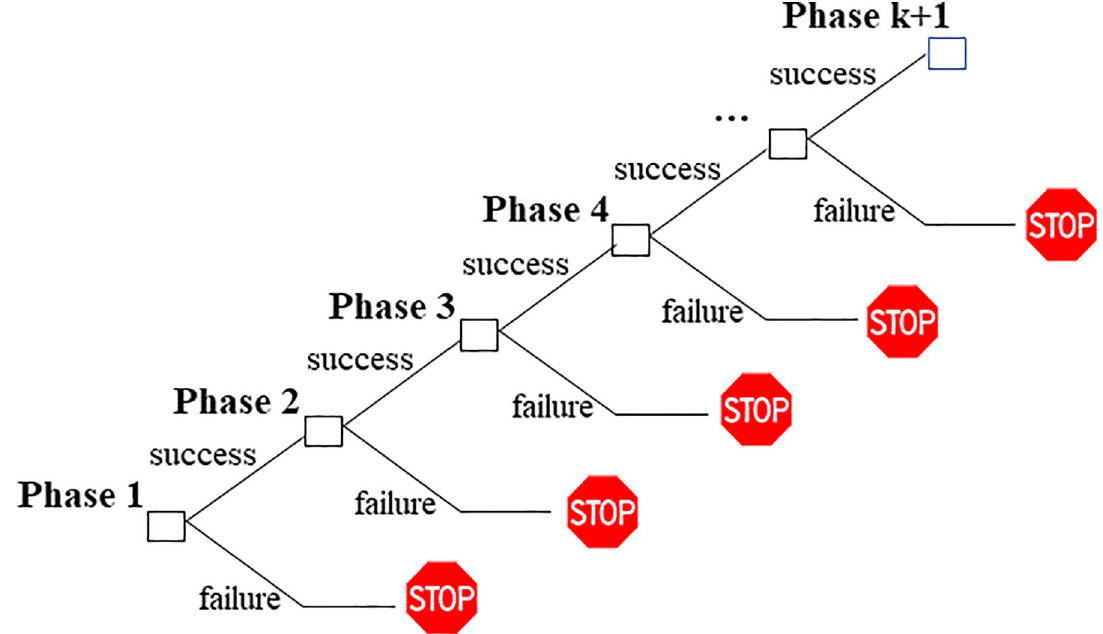
Fig 1. The optional nature of a sequential investment project. Source: Authors’ own